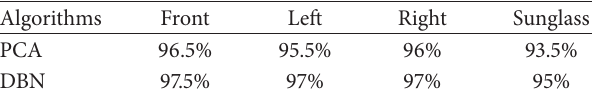
Table 1: Results of the second stage.